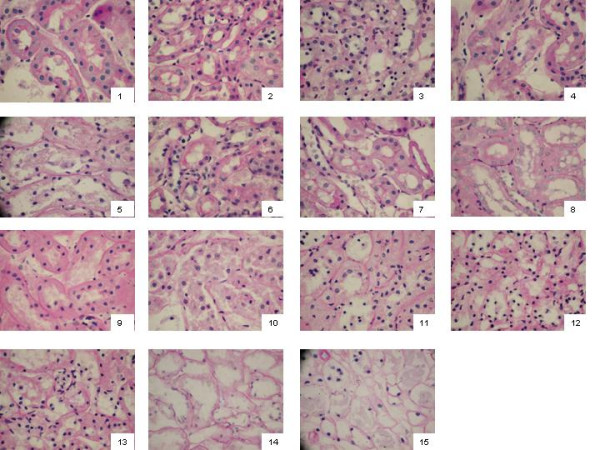
Kidney biopsy specimens stained with PAS. See text and table for histology scores and for description of solution and temperature used to preserve kidneys.